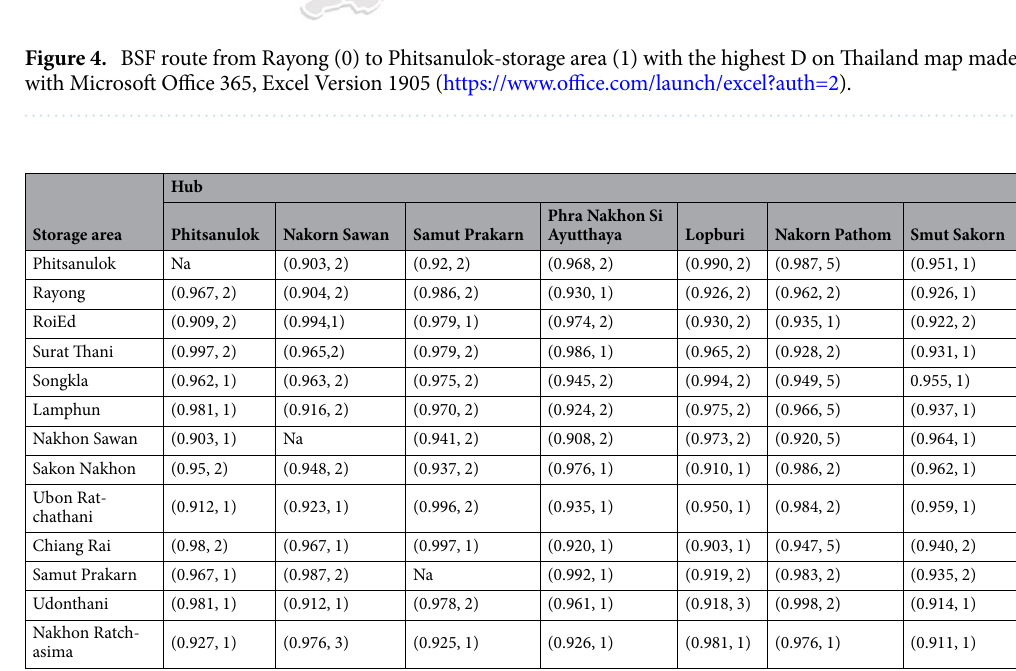
Table 5. Overall desirability and its BSF route (D, Rt) from all storage areas to selected central hubs.